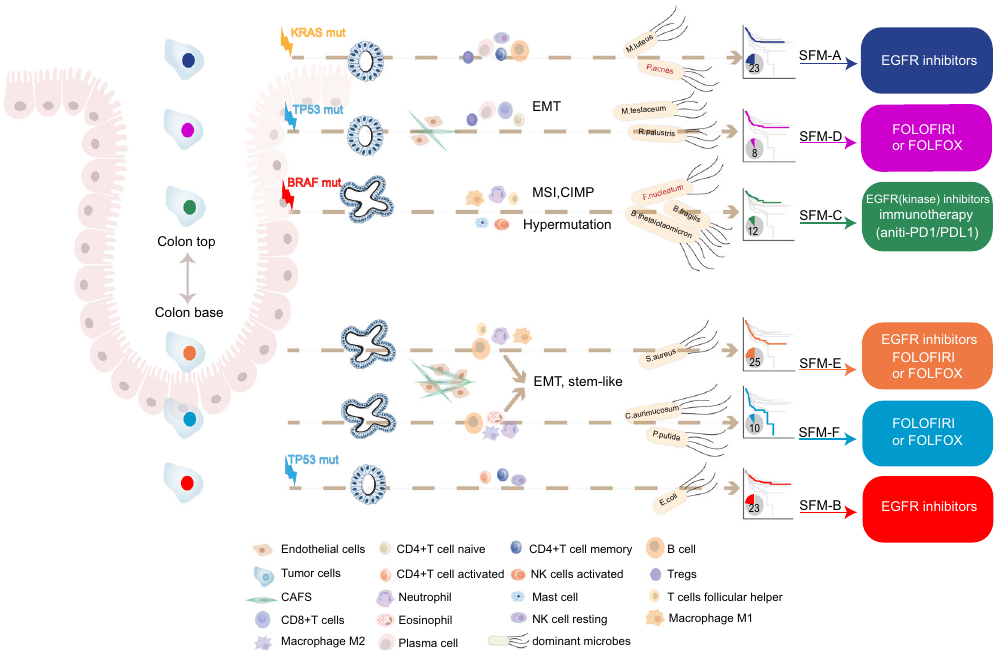
Fig. 6 Summary of characteristics of SFM subtypes. These included pathological features, genomic markers, TME, epigenetic changes, gut microbes, prognostic value, and possible SFM subtypes-guided therapies for